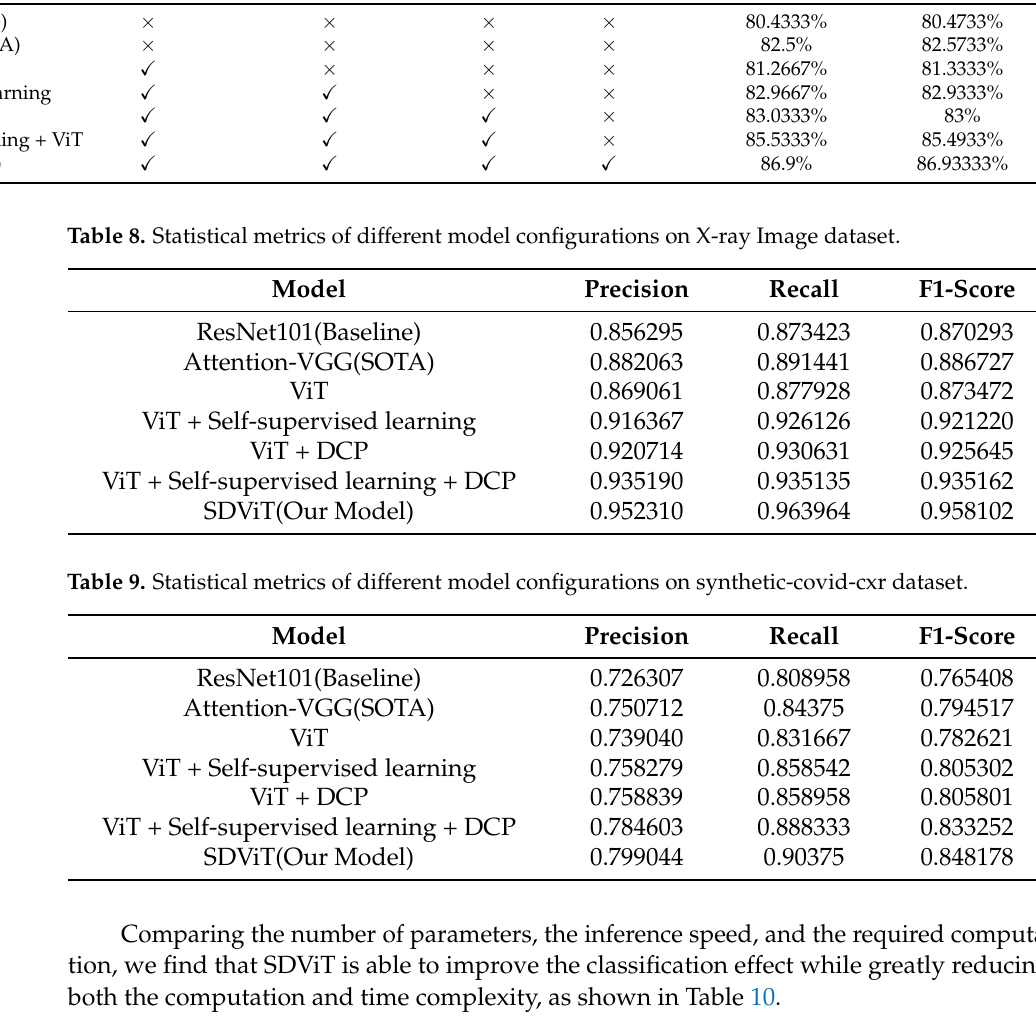
Table 7. Accuracy of different model configurations on synthetic-covid-cxr dataset. Model